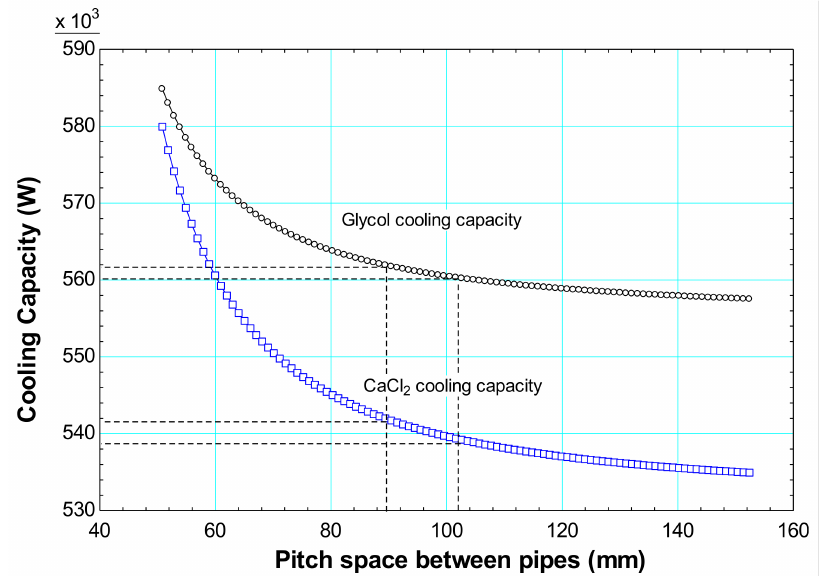
Figure 10. Cooling performance at various pitch distances with glycol and CaCl 2 as coolant.